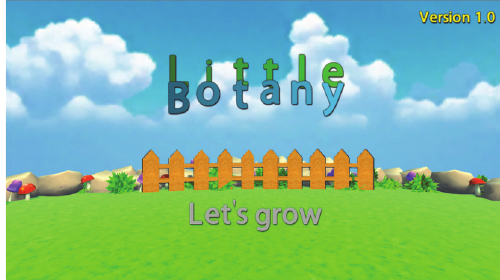
Figure 8: Start-game scene in Little Botany.